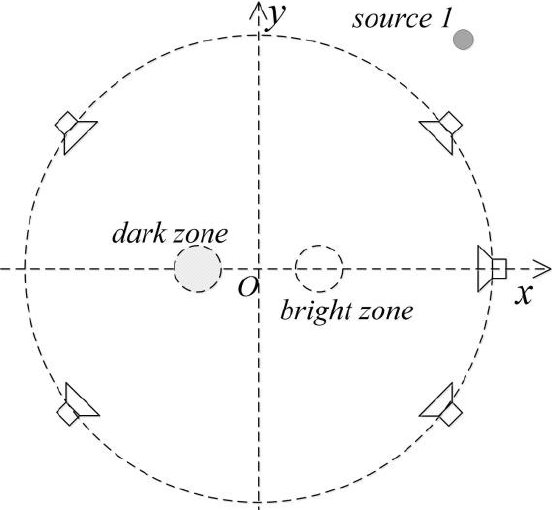
Figure 2. Diagram of 5-channel system setup.